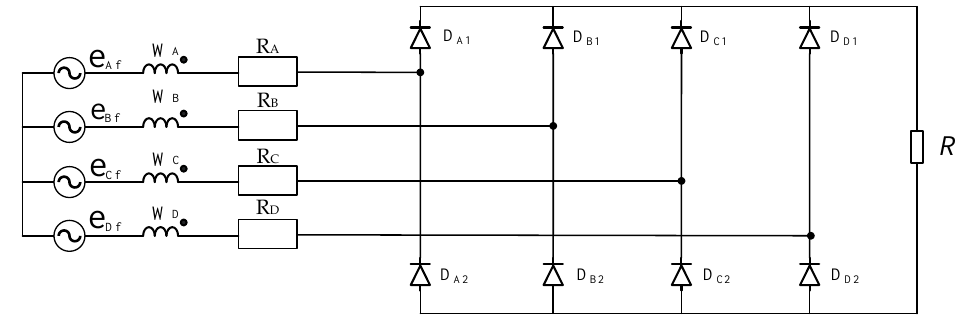
Figure 2. ( a ) DSPM machine [22]. ( b ) HEDSM machine [23].